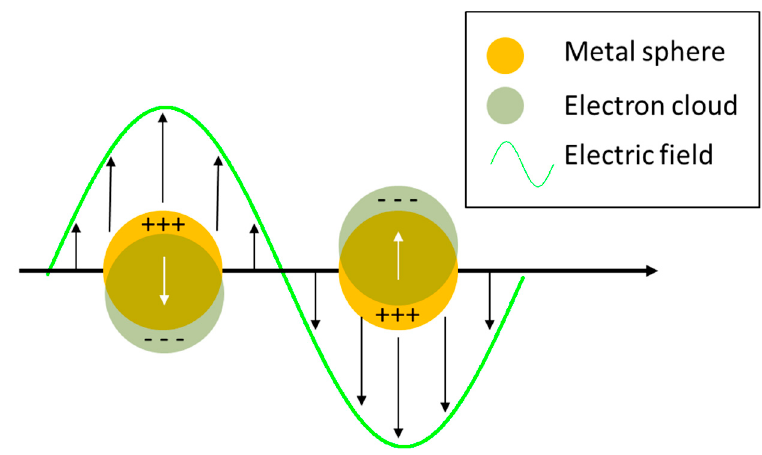
Figure 7. Collective oscillations of electrons in a spherical nanoparticle under the action of the external electric field.